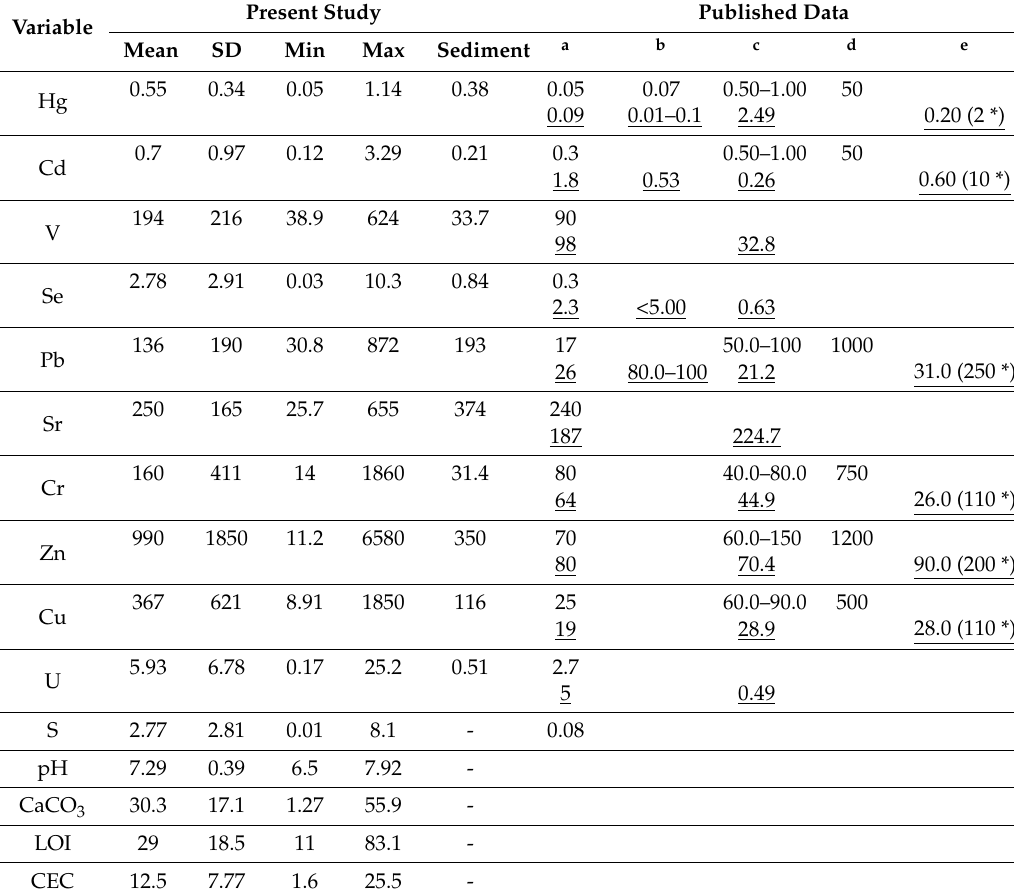
Table 2. Values (mean, SD, min, and max) of variables measured in Labin soil (n = 16), and sediment (n = 1) samples compared with relevant published data a–e . Underlined values refer to sediment reference levels. S, LOI, and CaCO 3 in %, trace elements in in mg/kg, and CEC in mEq/100